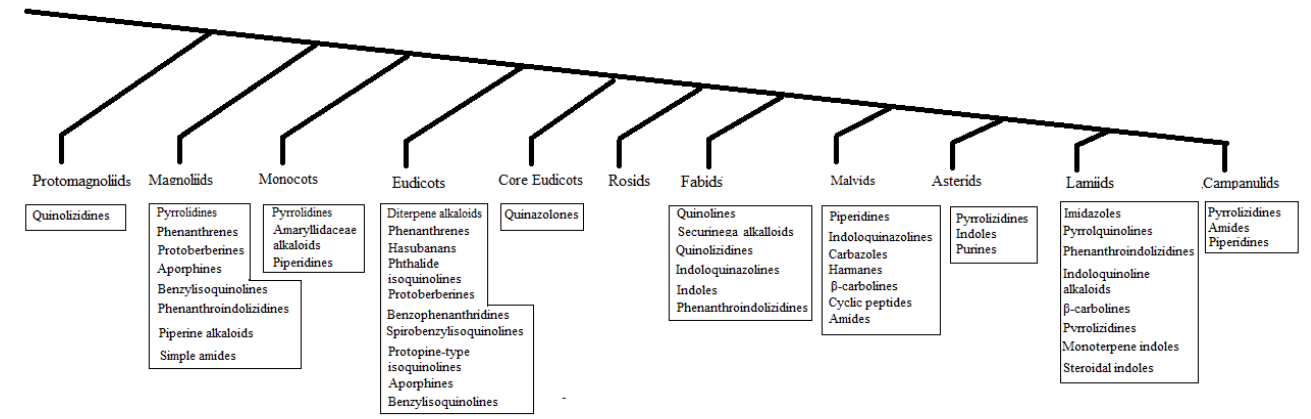
Figure 1. The phylogenetic distribution of antibacterial and/or antifungal alkaloids in angiosperms. Table 1. The chemical structures of antibacterial and/or antifungal alkaloids and their botanical origin.